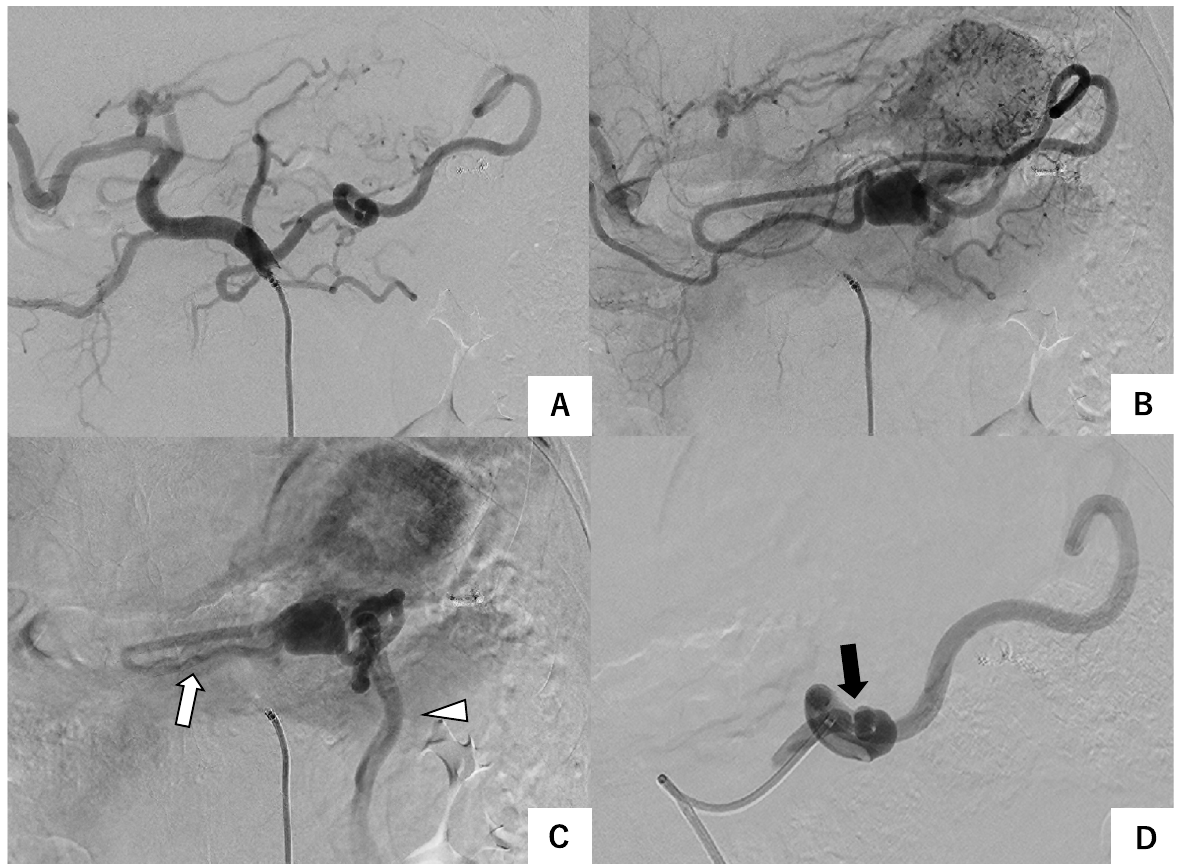
Fig. 2 Angiography of the celiac artery showed that the dilated omental artery was revealed continuously from the splenic artery ( A ), turned over, headed toward the vascular sac ( B ), and returned to the omental vein (white arrow) and left colonic vein (white arrowhead) ( C ). A stenosis (black arrow) due to ligation at the time of splenectomy was observed in the splenic artery ( D